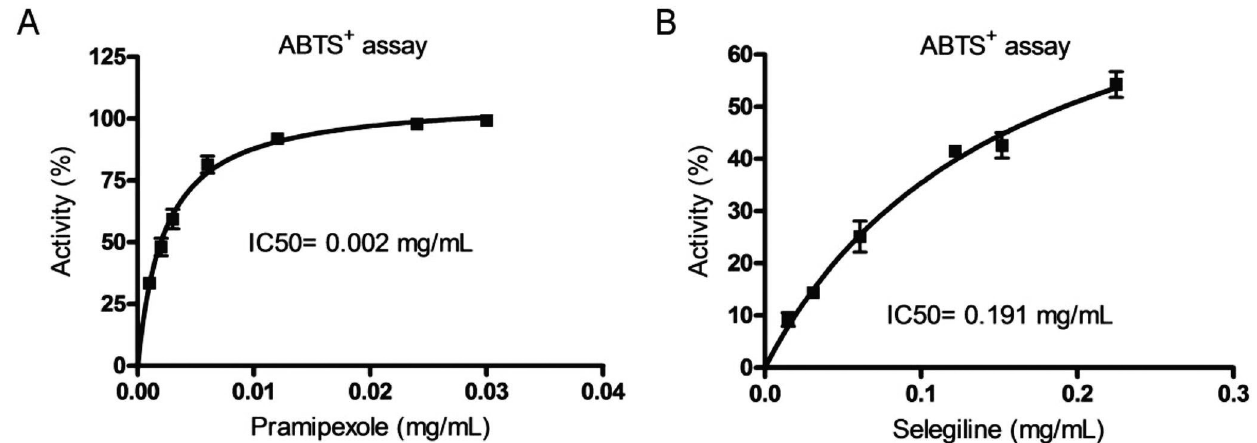
FIGURE 2 - Free radical scavenging activity of pramipexole (A) and selegiline (B) in the ABTS + assay. Data are means ± standard error mean (SEM) of triplicate values and are presented as percentage of inhibition relative to